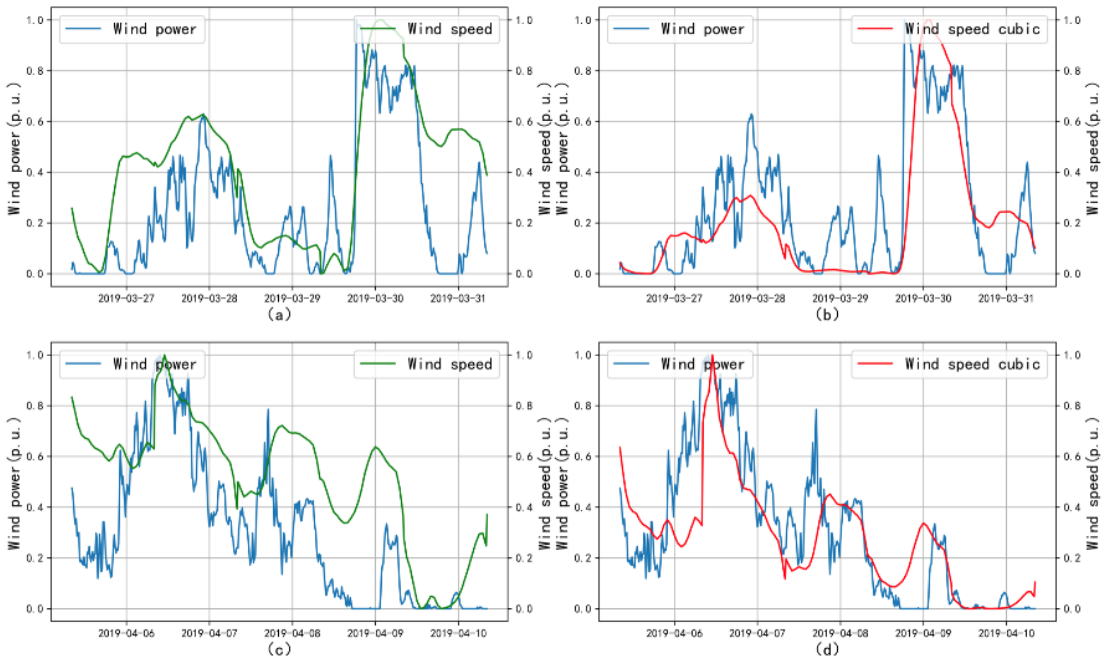
Figure 1. Comparison between numerical weather prediction (NWP) speed and wind power. ( a ) Wind speed comparison in scenario 1; ( b ) wind speed cubic comparison in scenario 1; ( c ) wind speed comparison in scenario 2; ( d ) wind speed cubic comparison in scenario 2.